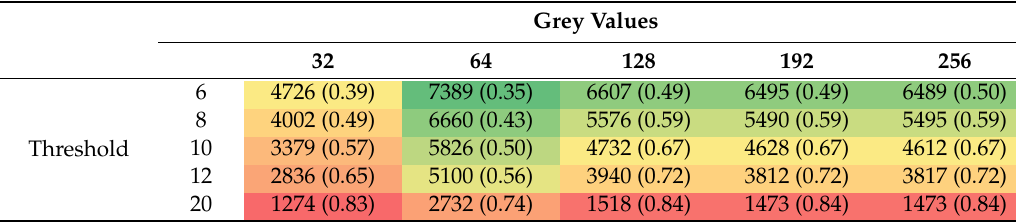
Table 2. Number of matching stones between the automatic and manual detection methods under di ff erent frame conditions at a bu ff er size of 1.50 m. Color scale indicates high values in green and low values in red. The proportion to the total number of automatically detected stones are in parentheses.